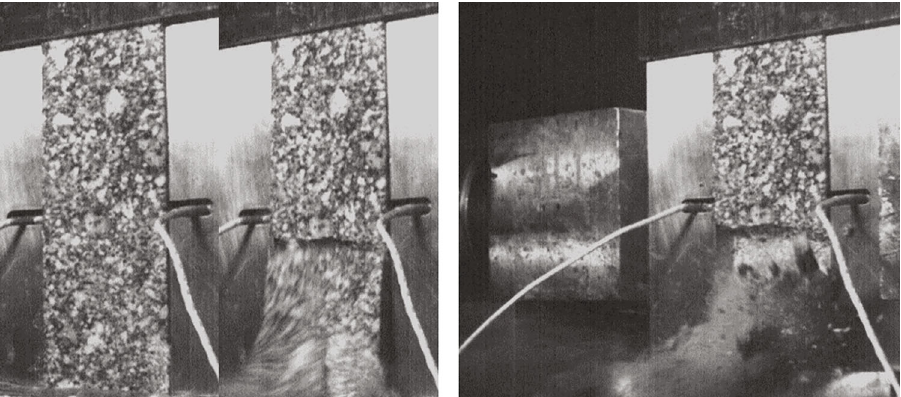
Figure 4: High-speed photography of failure process in rock burst experiment. Table 3: Stresses in di ff erent stages during rock burst experiment.